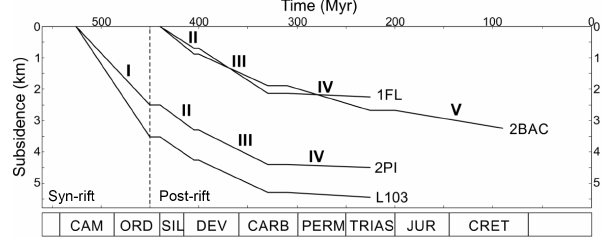
Figure 11. Sediment thickness as a function of sediment age for wells 1FL, 2BAC and 2PI and seismic line L103 (at the distance of 40km – Fig. 9). Labels I to V indicate stratigraphic sequences described in the